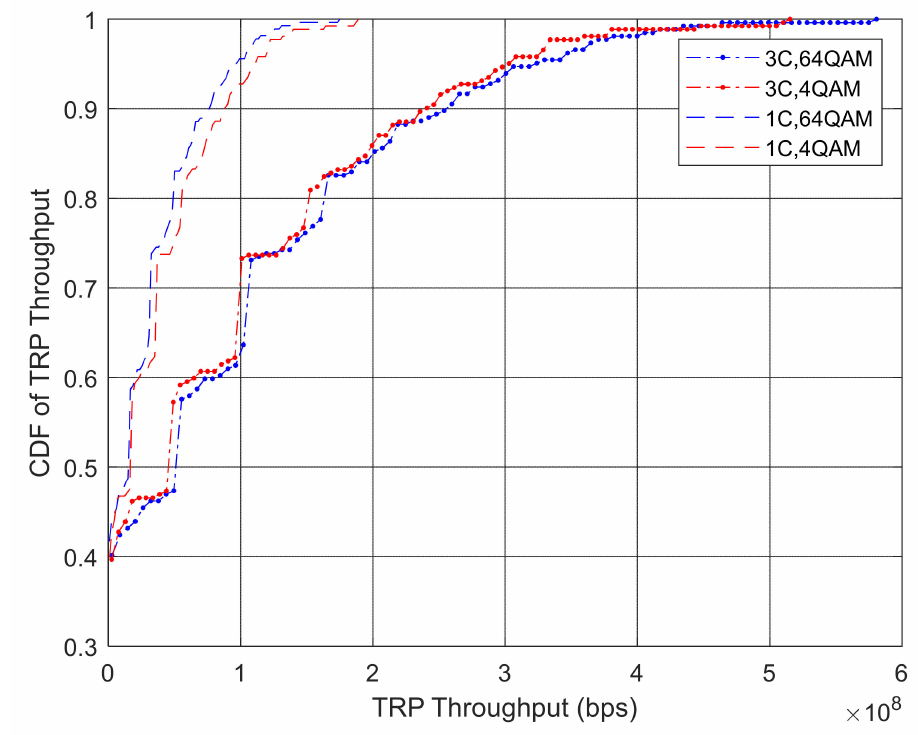
Figure 9. CDF of TRP throughput vs. TRP throughput (bps) for UMa scenario with N tx = 5 N u , N f = 4, N af = 3, N s = 5, N a = 2, N rx = 5, 64-QAM (11.75 bpcu per user) and 4QAM (5.75 bpcu per user).